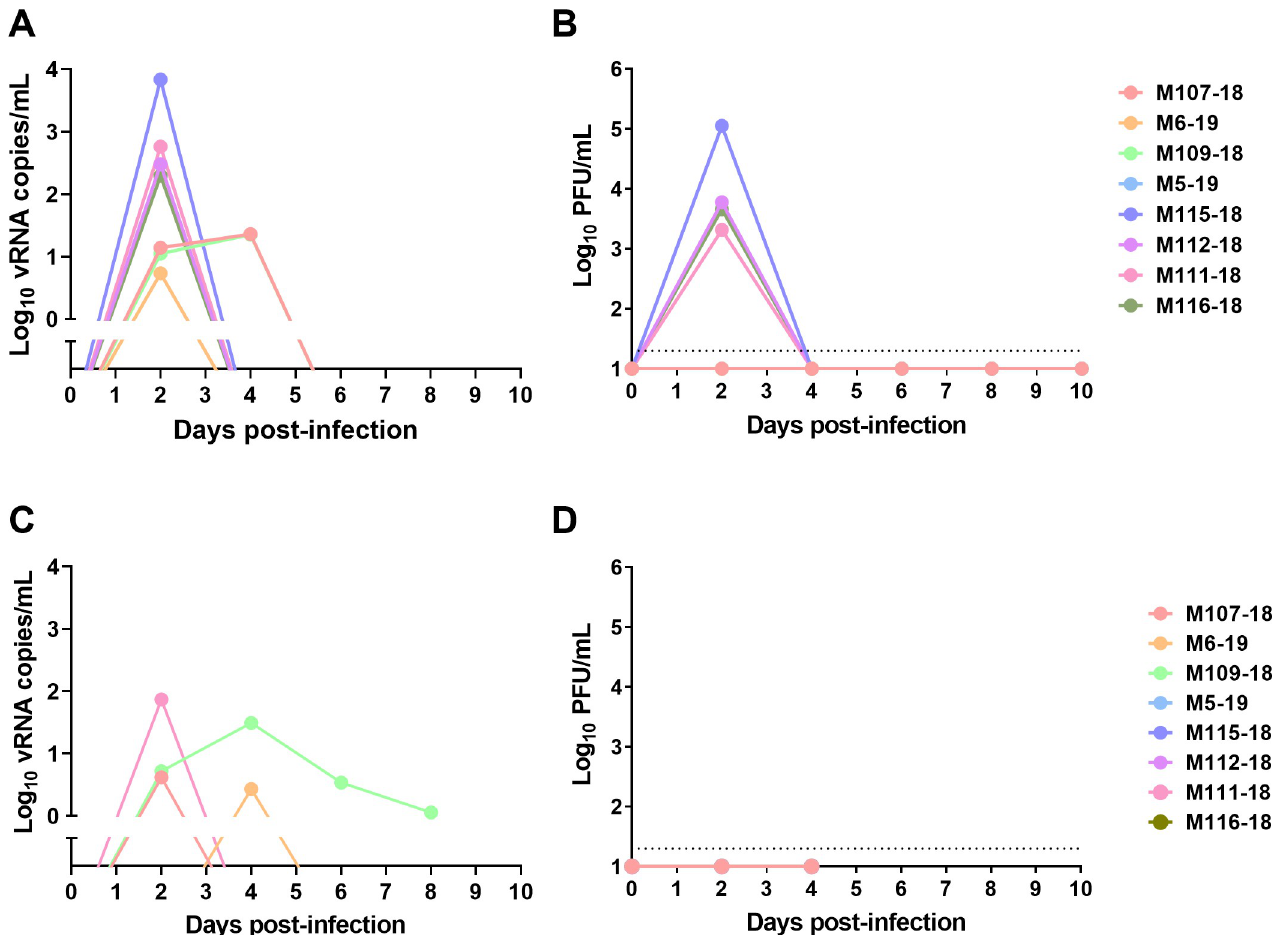
Fig 8. Longitudinal plasma viremia and nasal swabs during VEEV infection. Longitudinal plasma and nasal swabs were taken every 2 days after infection. vRNA was measured by semi-quantitative q-RT-PCR and infectious virus by plaque assay. (A) plasma vRNA; (B) plasma viremia; (C) nasal swab vRNA; (D) nasal swab plaque assay. Log 10 vRNA titers in A and C have background subtracted. LOD of plaque assay is indicated by horizontal dashed line in B and D.